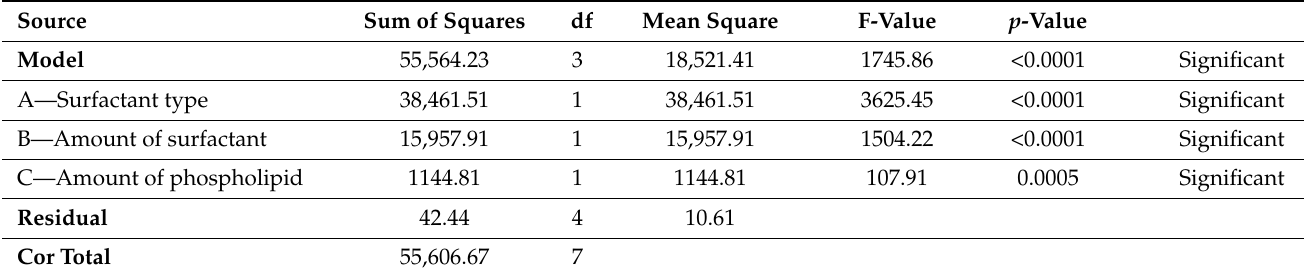
Table 5. ANOVA analysis for the effect of formulation factors on the particle size (Y2).